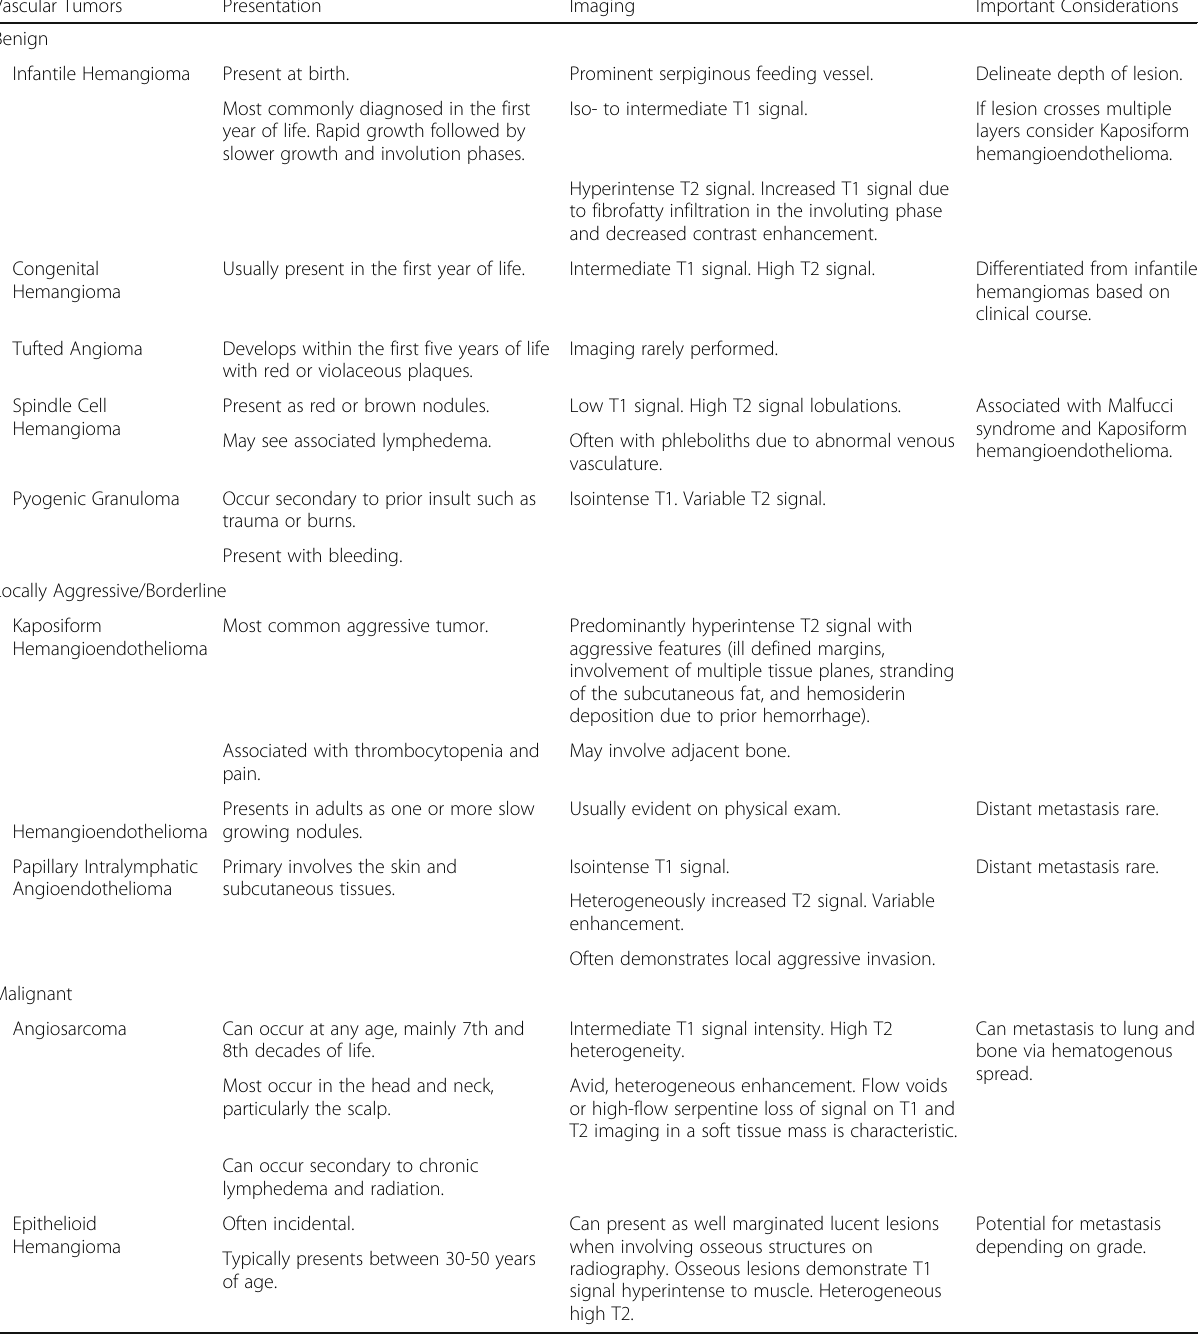
Table 1 Characteristics of benign, locally aggressive/borderline, and malignant vascular